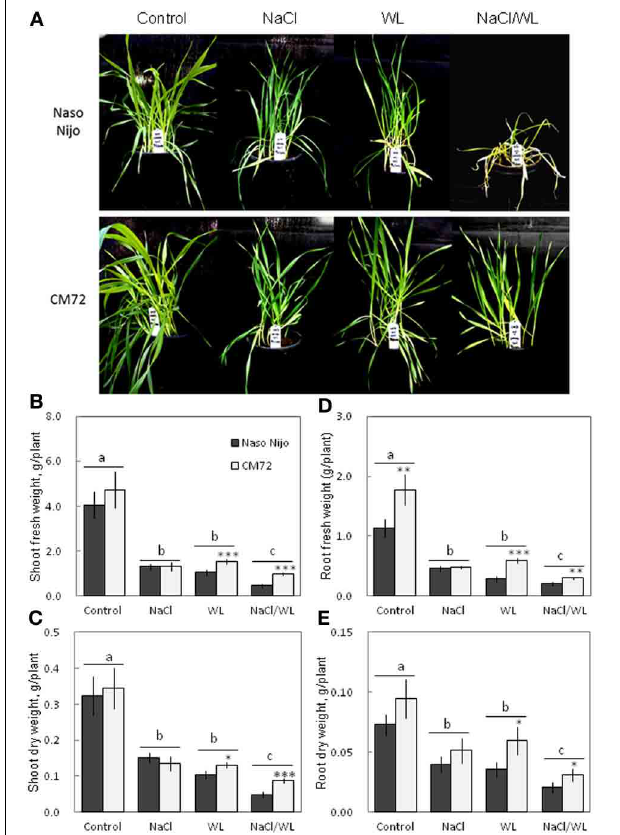
FIGURE 1 | Effects of separate and combined salinity and waterlogging stresses on growth of two contrasting barley cultivars in sandy loam. Dark bars, Naso Nijo; light bars, CM72. One-week old barley seedlings were subjected to one of four treatments: Control (no NaCl; well drained), NaCl (well-drained pots watered with 200mM NaCl solution), WL (submerged pots; no NaCl), NaCl/WL (pots submerged in 200mM NaCl solution). Plants were harvested for morphological (A) and biomass analysis (B–E) 14 days after the onset of treatment. For growth condition and media composition, refer to the Materials and Methods section. Mean ± SD ( n = 5). Different lower case letters indicate the significant difference between treatments (averaged for both genotypes) at P < 0 . 01. Asterisks indicate the significant difference between cultivars within treatment at ∗ P < 0 . 01, ∗∗ P < 0 . 001, and ∗∗∗ P < 0 .